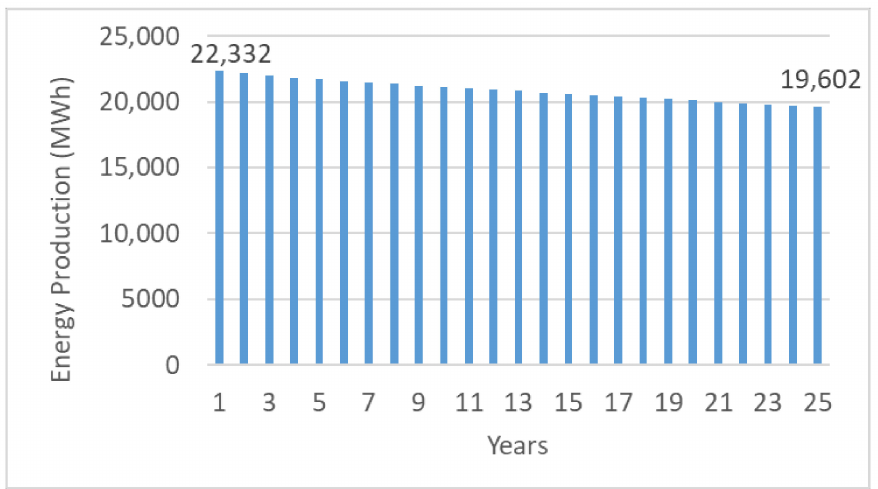
Figure 4. Evolution of energy production with the degradation rate.